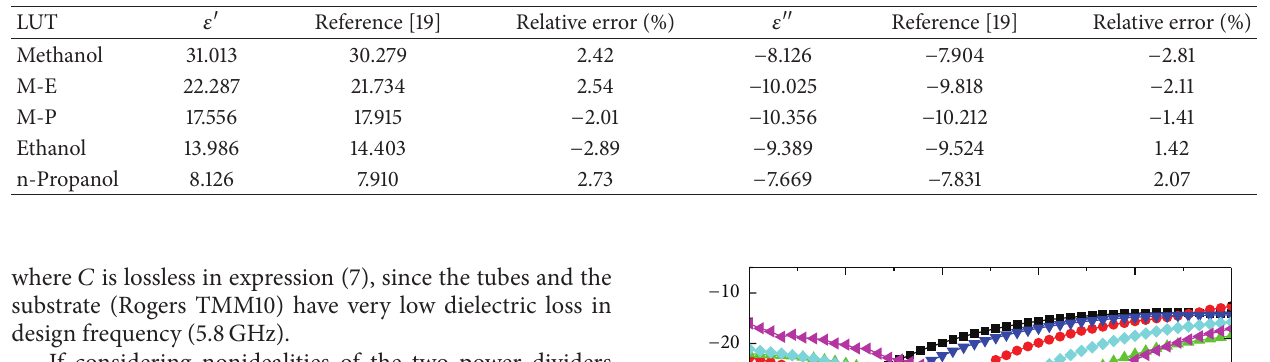
Table 1: Measurement results for methanol, M-E, M-P, and n-propanol.